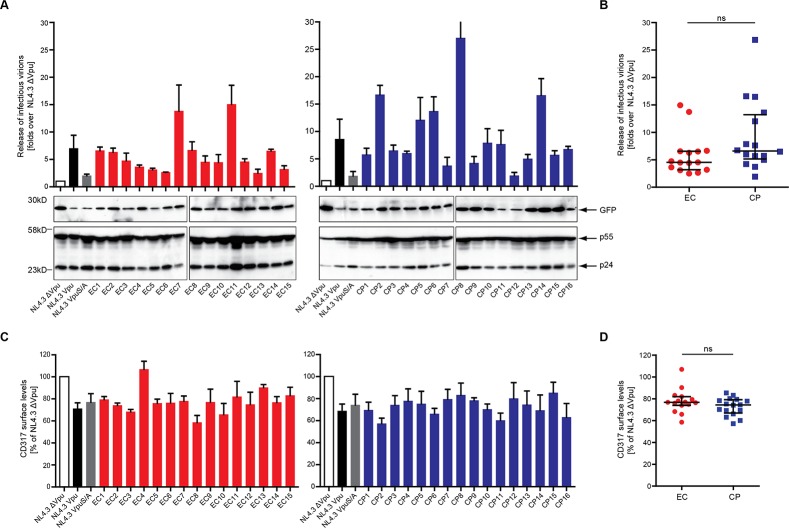
Recovery of HIV-1 particle release by patient-derived Vpus.TZM-bl cells were transiently transfected with HIV-1NL4.3 Δvpu provirus plasmids and the indicated Vpu allele or controls. 48 h post transfection, the resulting viral supernatants were assayed for infectivity on TZM-bl indicator cells to determine the amount of infectious virions produced. TZM-bl cell lysates from one replicate of the assay were subjected to Western blot detection, and TZM-bl cells from the same replicate were harvested and assayed for cell-surface level of CD317/tetherin. A) The yield of infectious HIV-1 in the supernatant and cell-associated levels of GFP, p24CA, and p55Gag were analyzed. HIV-1 particle release in the supernatant was assessed by measuring the induction of Luciferase units (top) in infected TZM-bl cells. Values (y axis) are normalized to that of control NL4.3Δvpu, which was set to 1, error bars represent the standard error of the mean (SEM) for three independent experiments. Western blot results show the expression level of GFP, p24 and p55 in one representative experiment. B) Comparison of enhancement of virion release mediated by EC and CP Vpu alleles. Statistical significance was assessed using two-tailed Mann-Whitney U-Test (p = 0.07), bars represent median and interquartile ranges. C) CD317/tetherin cell surface downregulation by patient Vpu. TZM-bl cells transfected with HIV-1 NL4.3 Δvpu and the indicated VpuIRESGFP plasmids were harvested 48 h post transfection and CD317/tetherin cell surface levels quantified by flow cytometry. The y-axis represents the relative CD317/tetherin cell surface levels remaining normalized to control cells transfected with NL4.3Δvpu and IRESGFP (set to 100%). D) Comparison of CD317/tetherin cell surface levels in TZM-bl cells producing viral particles and expressing EC or CP Vpu alleles. Statistical significance was assessed using two-tailed Mann-Whitney U-Test (p = 0.29), bars represent median and interquartile ranges.